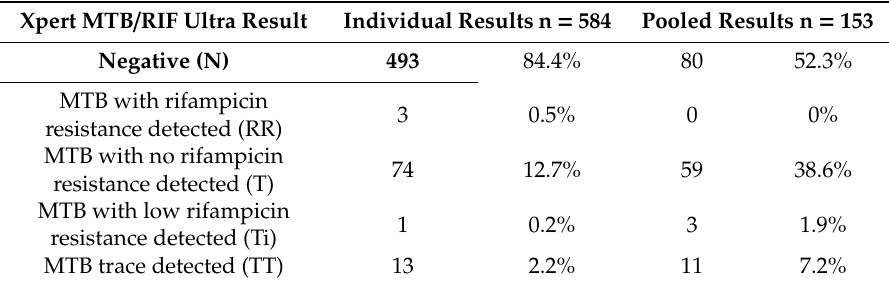
Table 2. Test results of individual and pooled Ultra testing in Cambodia.